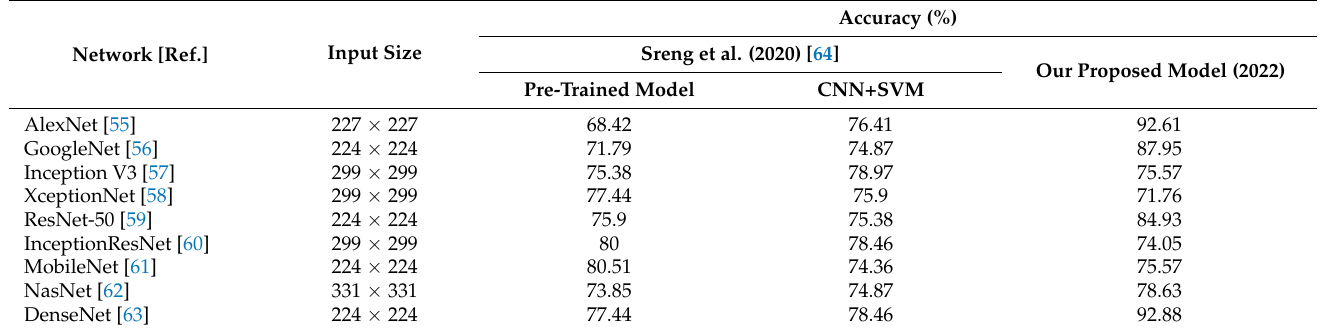
Table 4. Comparison results to a previous study that had similar